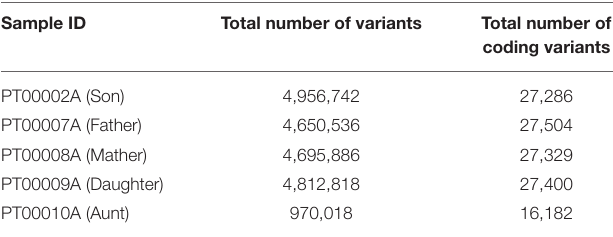
TABLE 2 | The total number of variants for all saliva samples and the total number of coding variants for each family